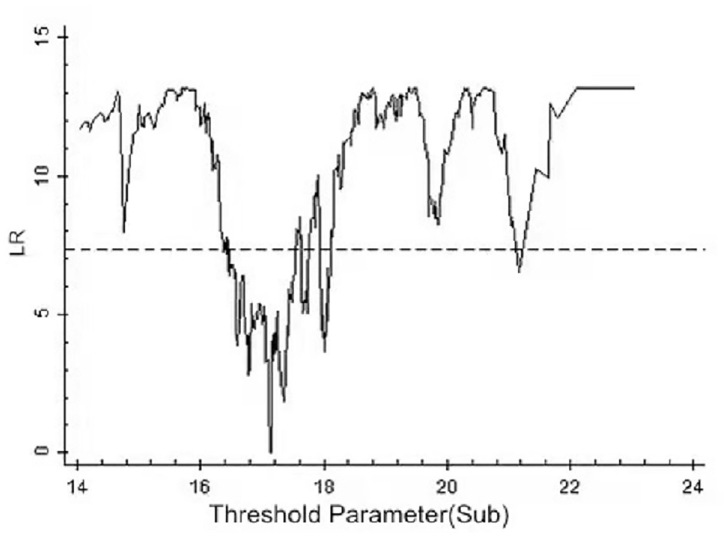
Fig 4. Estimated value and confidence interval of the second threshold in Model